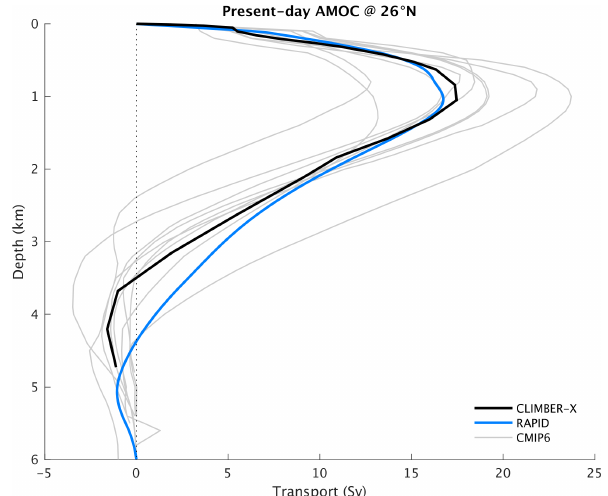
Figure 12. Vertical profile of the simulated Atlantic meridional overturning streamfunction at 26 ◦ N (black) compared to observa- tions from the RAPID array (Frajka-Williams et al., 2021) (blue) and a selection of CMIP6 models (grey). The CLIMBER-X and CMIP6 streamfunction is computed from historical simulations as the average over the time period from 2000 to 2014, while the RAPID values represent an average from 2004 to 2020.